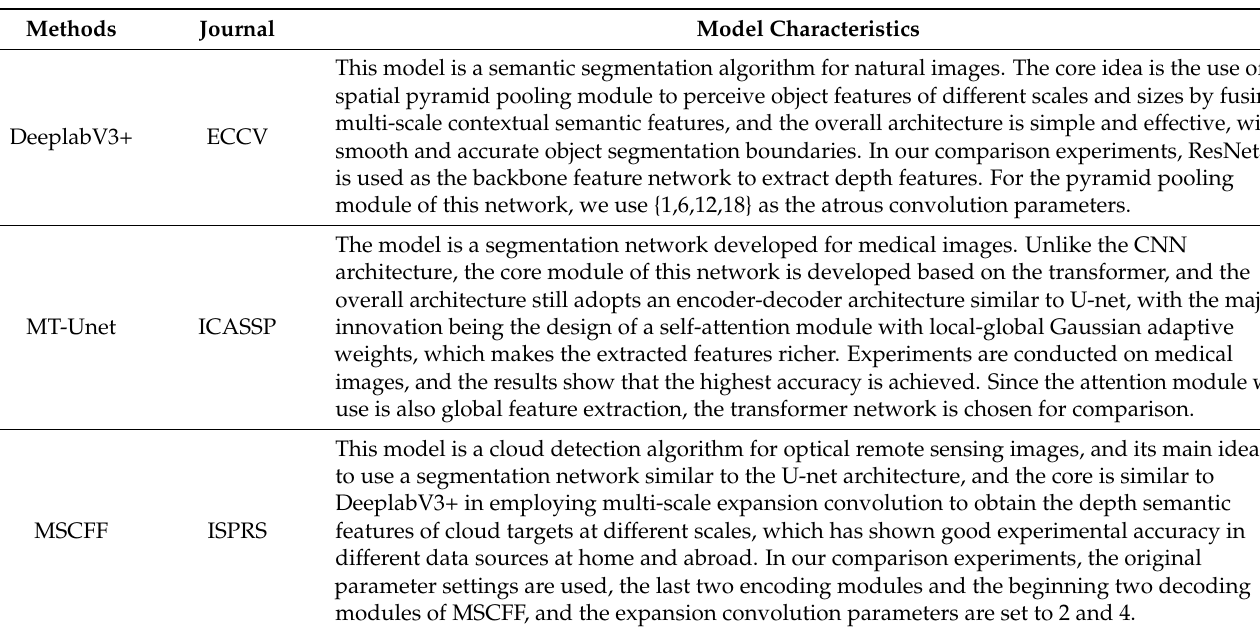
Table 5. Detailed analysis of different deep learning